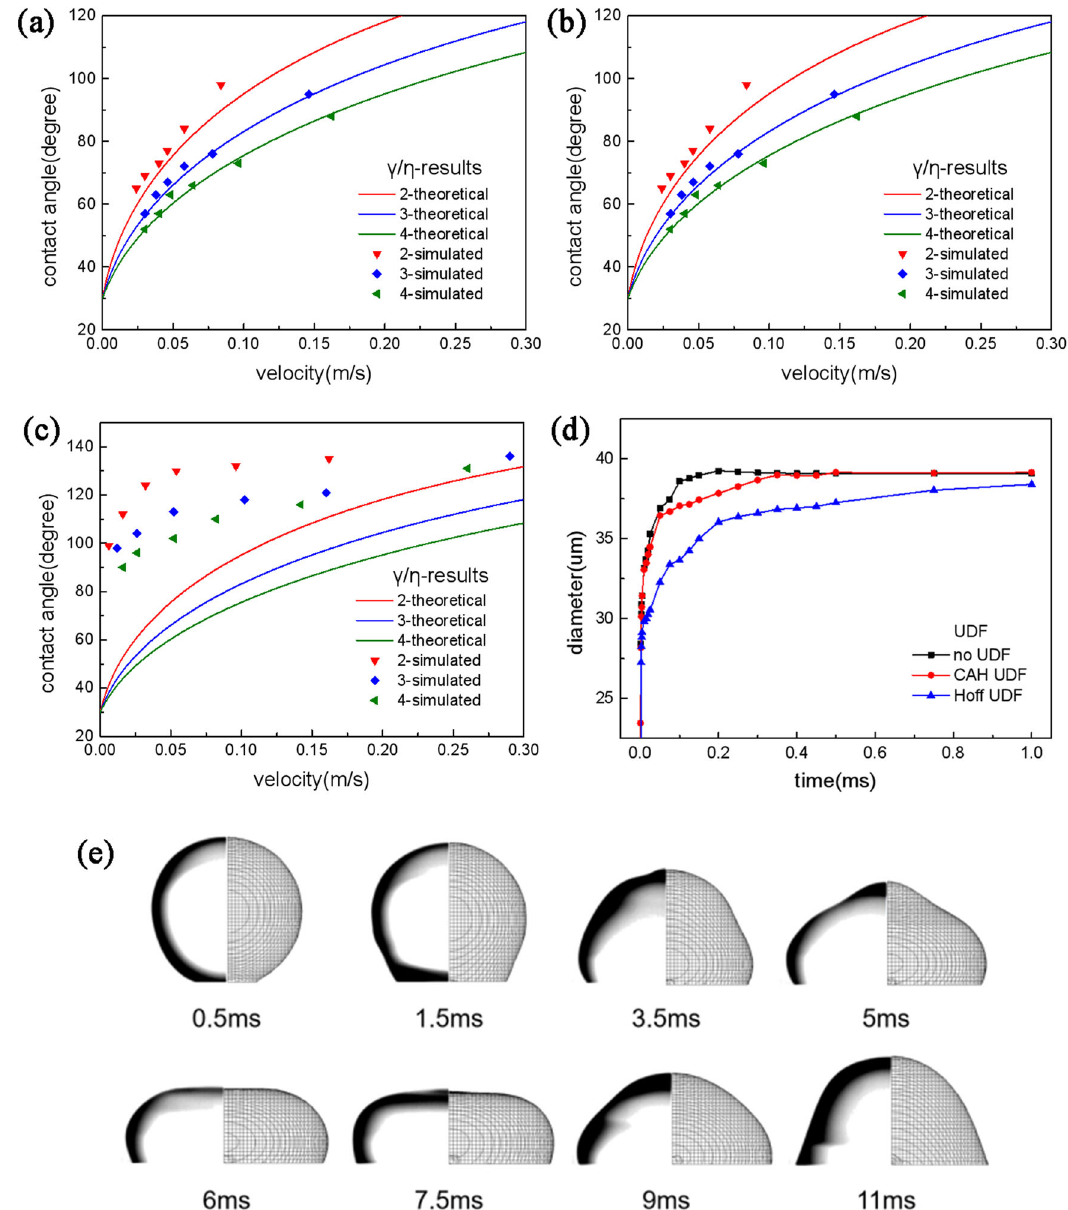
Fig. 3 Results of single droplet impact simulation. a Simulated results of cases without UDFs. b Simulated results of cases with the CAH UDF. c Simulated results of cases with the Hoff UDF. d Simulated time-dependent diameter of different cases. e Comparison of the simulated droplet and real droplet in ref. 56 . a – c Shows the relationship between derived simulated dynamic contact angle and moving velocity of the contact line. These fi gures show that results from cases without UDFs and cases with CAH UDF are in accord with the Hoffman function. In e , every picture is composed of photographs from ref. 56 (left part) and simulated shape from the case with CAH UDF (right